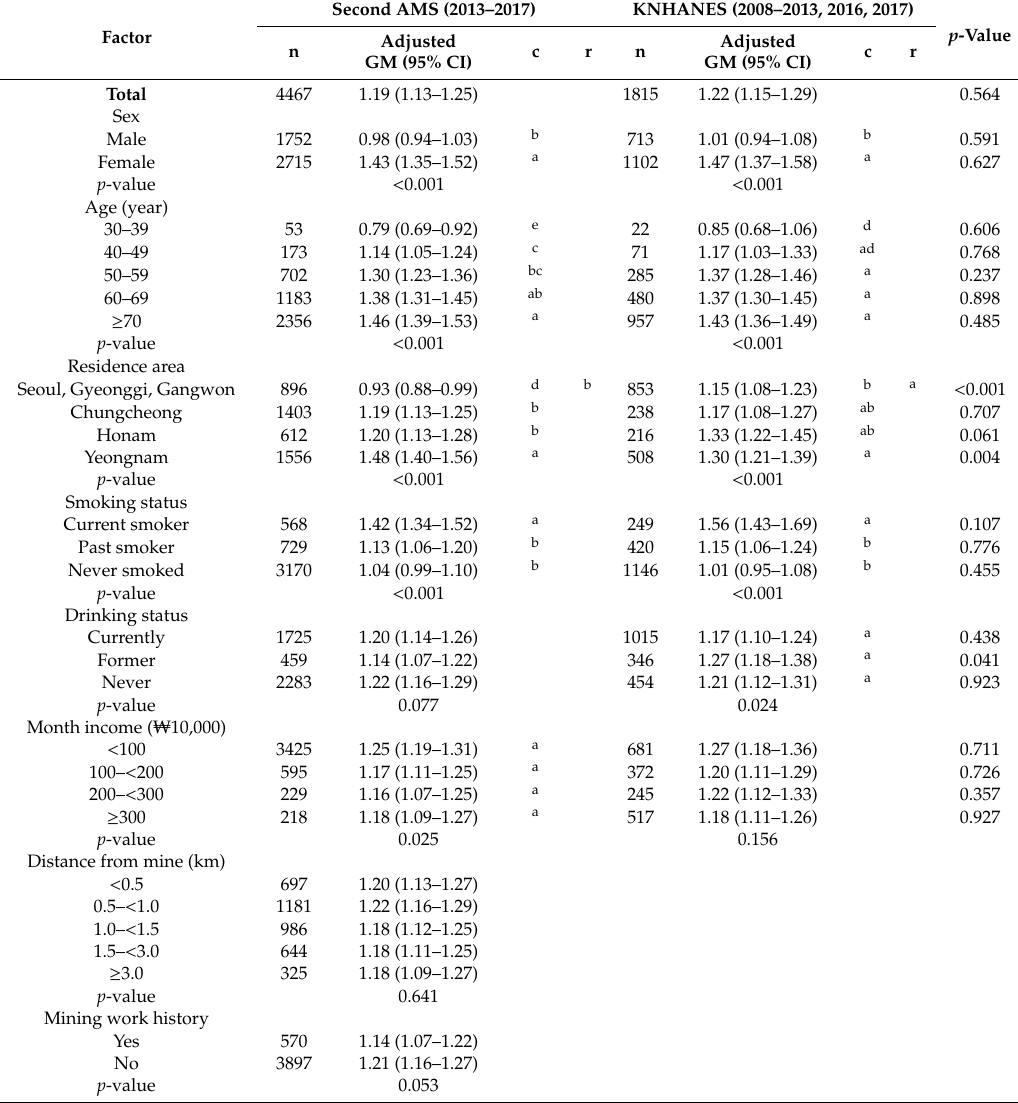
Table 3. Adjusted geometric means of the blood cadmium (Cd) concentration ( µ g /